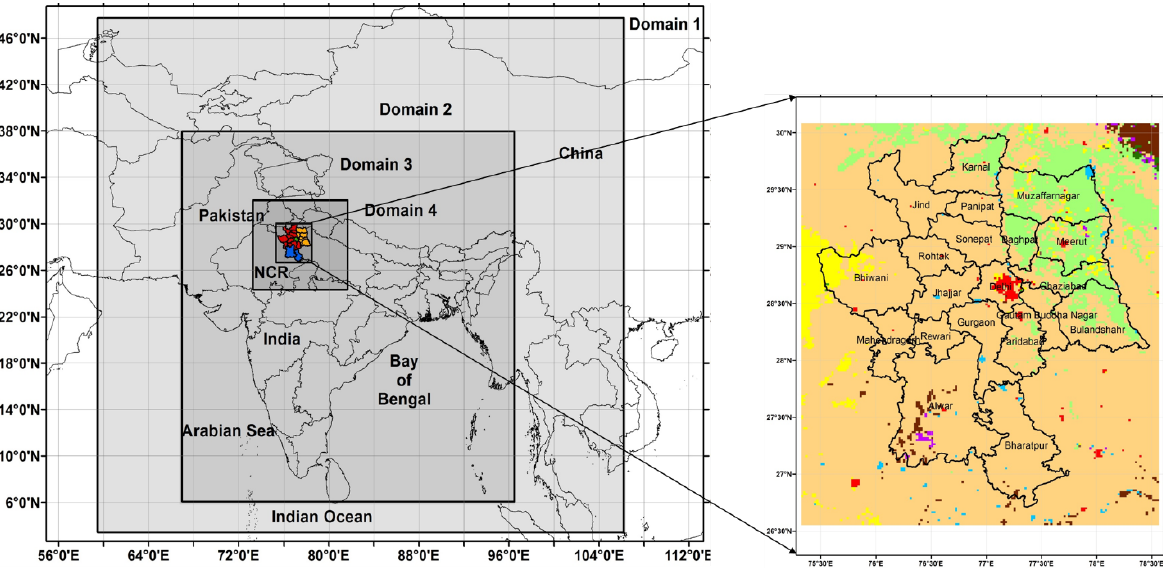
Figure 2. Simulation domains covering Asia (54 km x 54 km resolution) as domain 1, India (18 km x 18 km resolution) as domain 2, parts of north India (6 km x 6 km resolution) as domain 3, and domain 4 enveloping the National Capital Region of India (2 km x 2 km resolution). Table 1. Proposed emission scenarios for the different sectors for PM and NOx emissions (Source: NEERI, 2008).